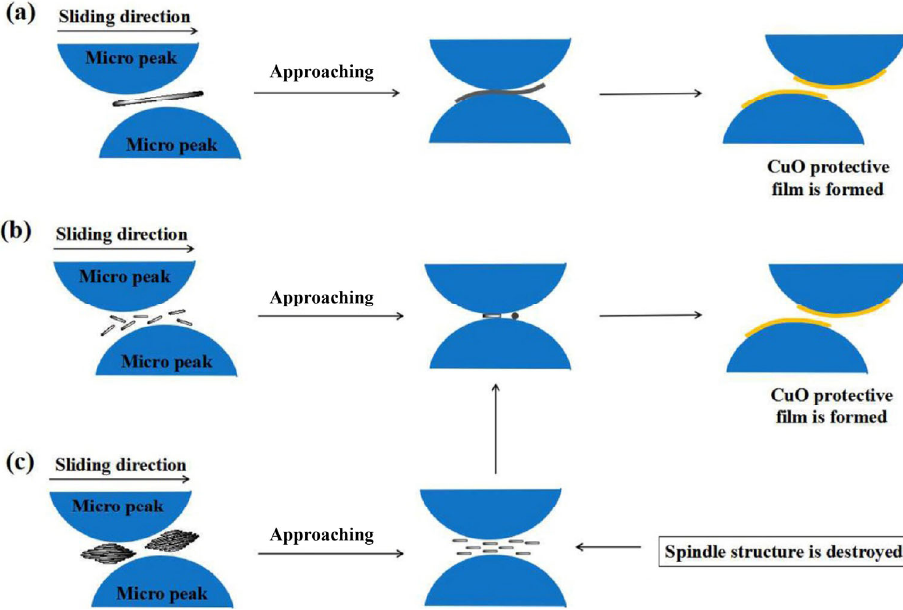
Fig. 13 The schematic of lubrication mechanisms under aqueous solution lubrication of (a) CuO nanobelts, (b) CuO nanorods, and (c) spindle CuO